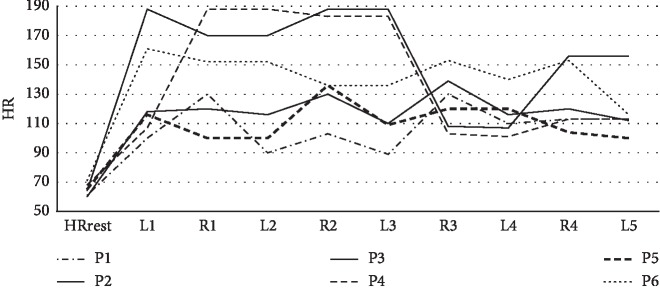
Maximum heart rate achieved in lessons (L1–L5) and subsequent recesses (R1–R4) in six participants (P1–P6) who reported academic stress in four or more lessons. HR: heart rate; HRrest: resting heart rate.